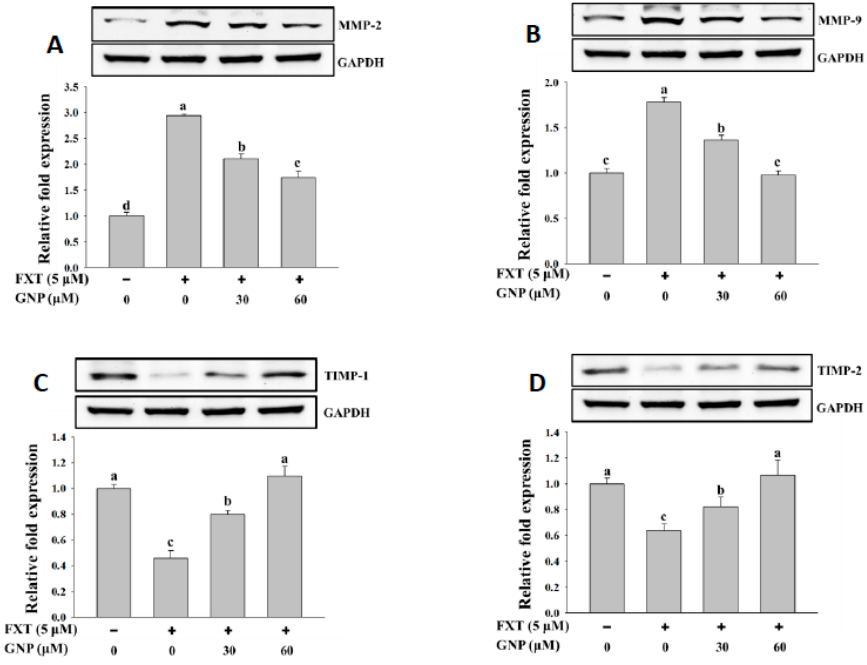
Figure 5. Cont. Figure 5.